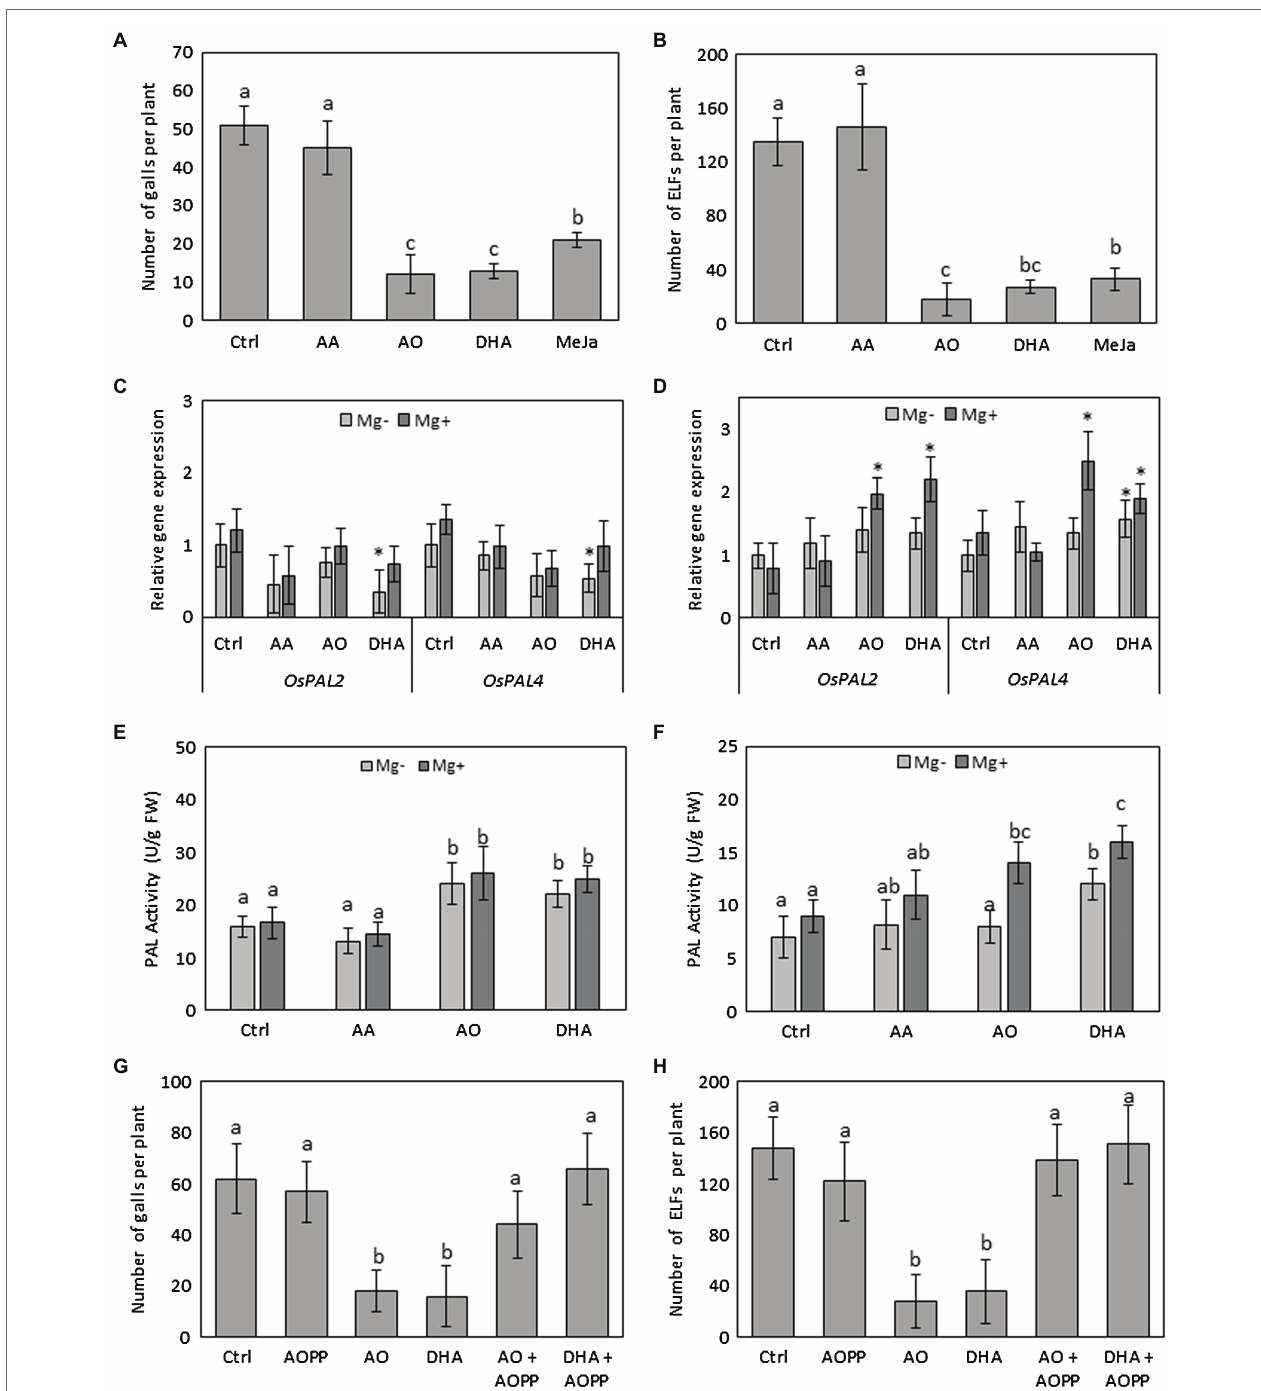
FIGURE 1 | Foliar spraying with AO and DHA induces systemic resistance in rice roots against M. graminicola through activation of PAL. Fourteen-day-old wild-type Nipponbare rice plants were sprayed with 20 mm of AA, 20 ml/unit of AO, and 20 mm of DHA or mock sprayed (Ctrl). After 24 h, plants from each treatment were inoculated with ≈ 250 s-stage juveniles of M. graminicola per plant. Total number of (A) galls and (B) egg-laying females (ELF) at 14 dai. (C,D) relative expression levels of phenylalanine ammonia lyase genes in shoot and root tissue at 3dai ( n = 3). (E,F) PAL enzyme activity in shoots or nematode-induced galls of infected and uninfected plants at 3 dai ( n = 4). (G,H) total numbers of galls and ELFs in L-2-aminooxy-3-phenylpropanoic acid (AOPP)-sprayed plants with and without DHA or AO treatment. For nematode infection experiments (A,B, G,H) , data represent mean ±SD ( n = 8) and data were analyzed by student t-test at p ≤ 0.05. For C,D , gene expression levels were normalized using three internal reference genes OsEIF5C , OsEXP , and OsEXPNarcai . Data are shown as relative transcript levels in comparison with the control plants (expression level set at 1). In c and d asterisks indicate significant differential expression between AO-treated and control plants (REST-analysis; α = 0.05). For E,F , data were analyzed by one-way ANOVA followed by Tukey’s post-hoc test. Different letters indicate statistically different means at p ≤